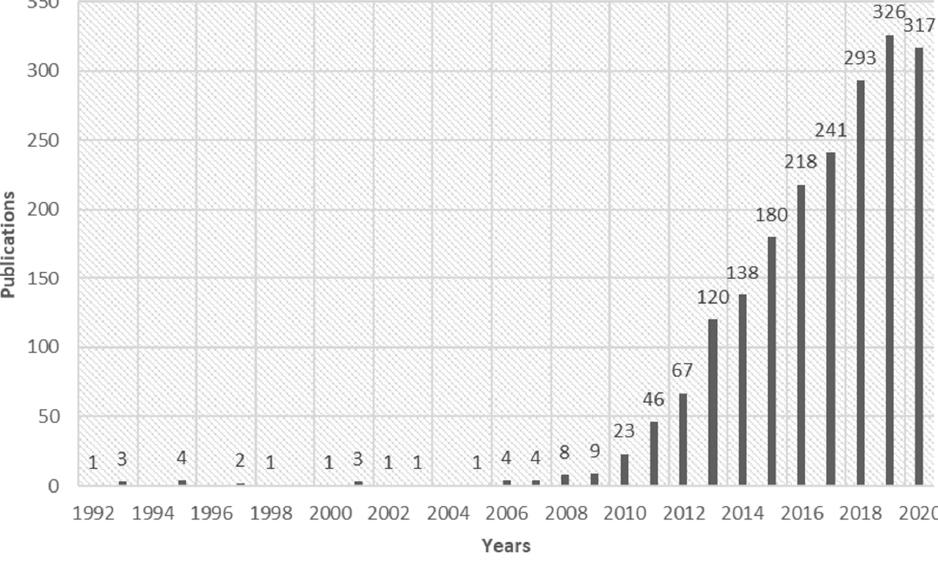
Figure 4. Growth trend of FO publication (1992–2020).